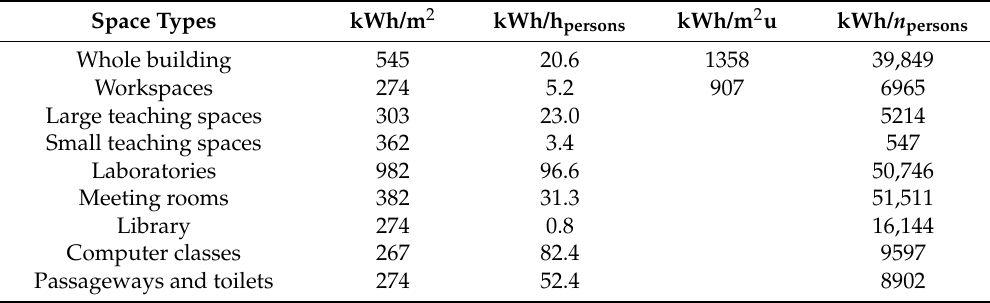
Table 5. Values of energy efficiency indicators for the various spaces before the renovation.